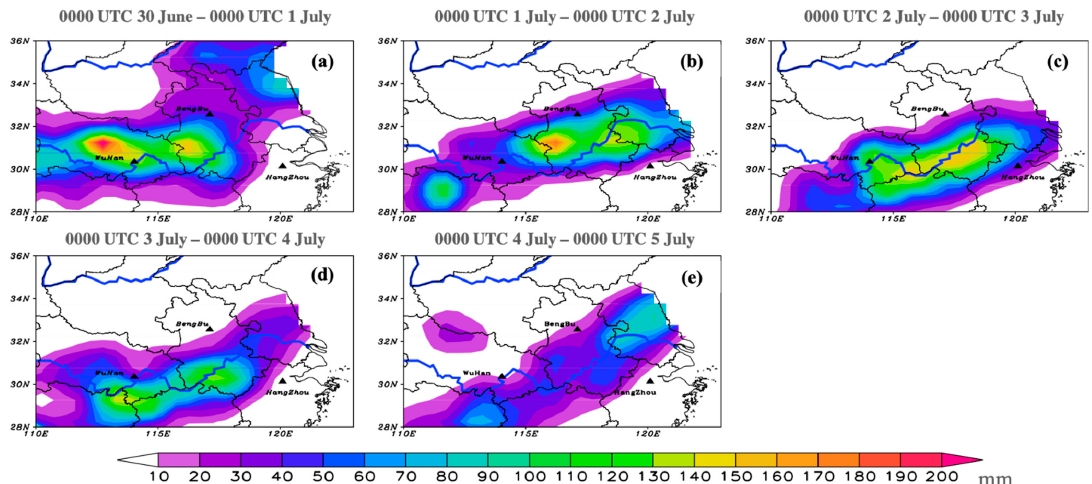
Figure 1. Spatial distributions of the observed 24-h accumulated precipitation (mm) in central eastern China valid starting at 0000 UTC on ( a ) 30 June, ( b ) 1 July, ( c ) 2 July, ( d ) 3 July, and ( e ) 4 July 2016. The observed precipitation is obtained from the daily rain gauge data interpolated to a 0.5° × 0.5° gridded domain. Thin black contours denote political boundaries and thick blue lines denote the Huanghe and Yangtze Rivers to the north and south, respectively. The location of Bengbu city represents the Huaihe River